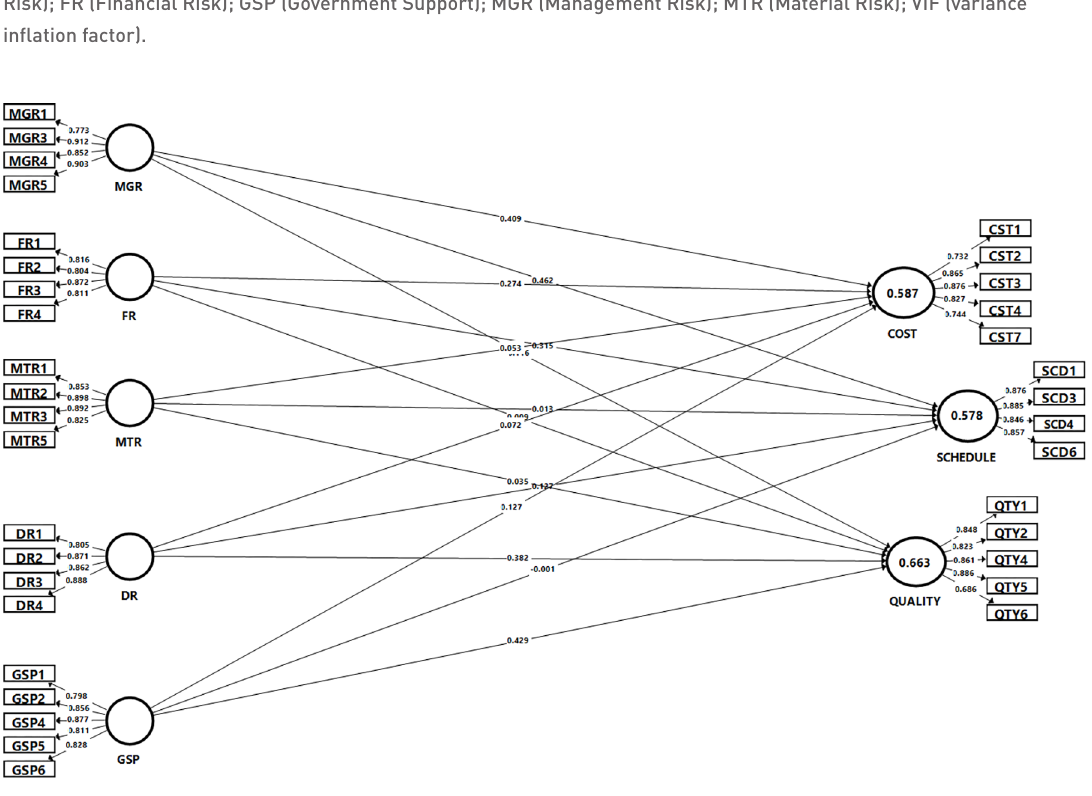
Figure 2. Measurement